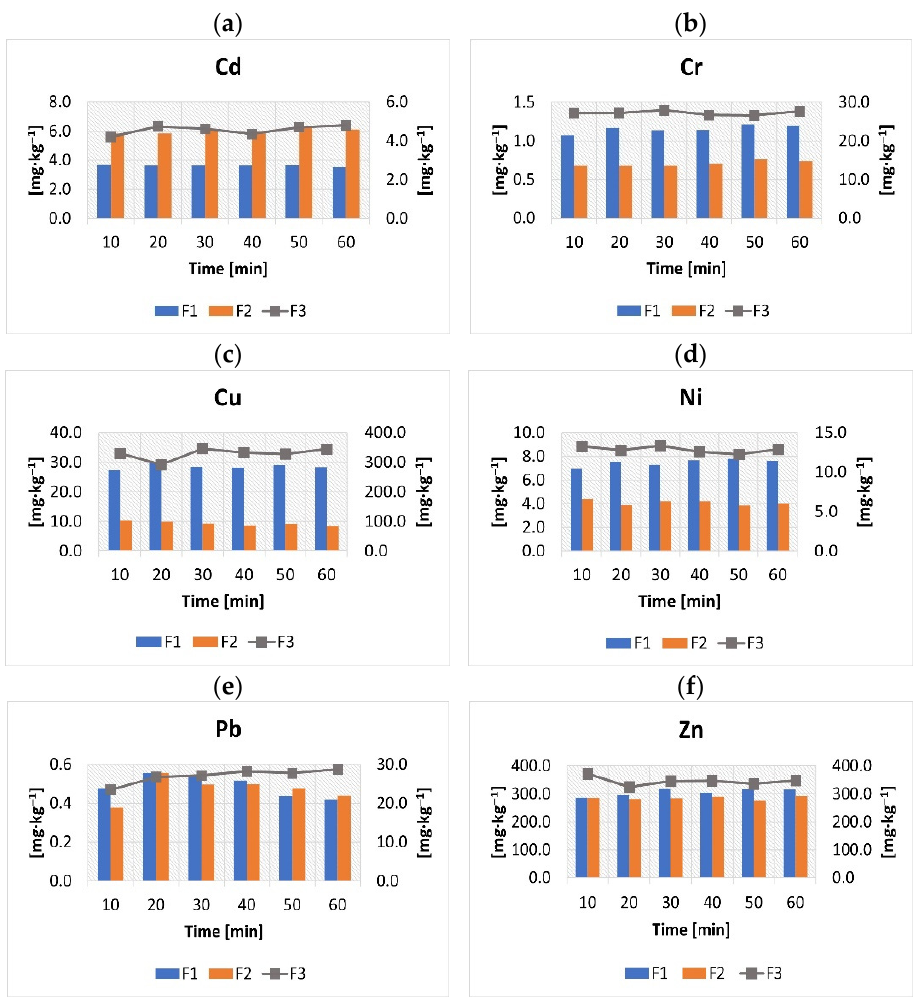
Figure 3. ( a – f ) The effects of the sonication time on the extraction of heavy metals in the three main fractions of the ultrasound-assisted BCR method.